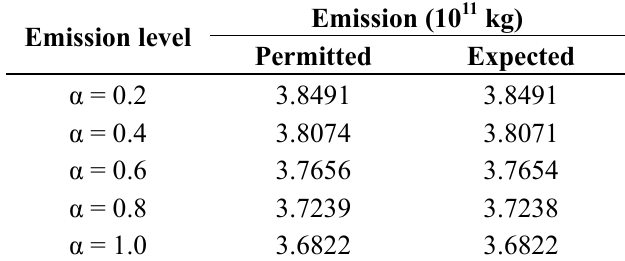
Table 9. Comparison of the permitted emission and expected